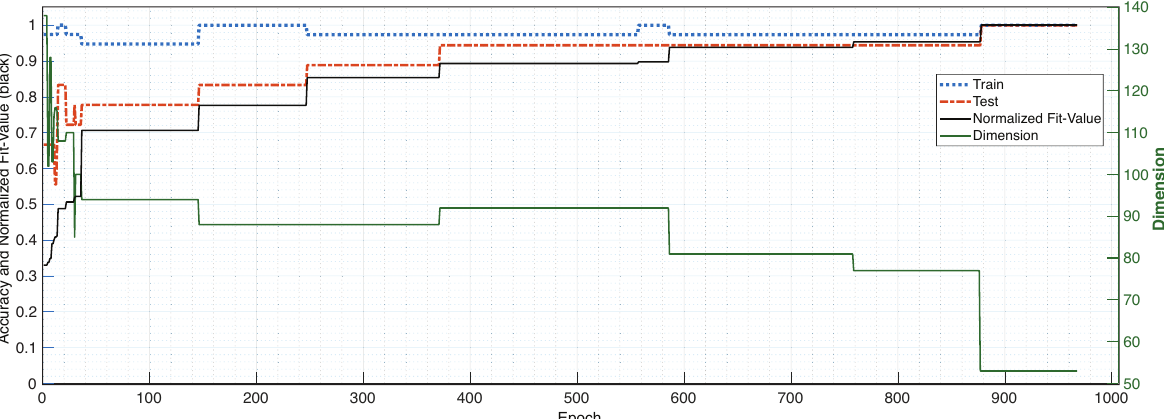
Figure 5. Feature Optimization Results (left y -scale) of the Embedded Genetic Algorithm Wrapper Method and the Dimension Reduction (right y -scale). Data: N = 56 ( p = 32, n = 24 ) , R = 38 ( p = 23, n = 15 ) , E = 18 ( p = 9, n = 9 )